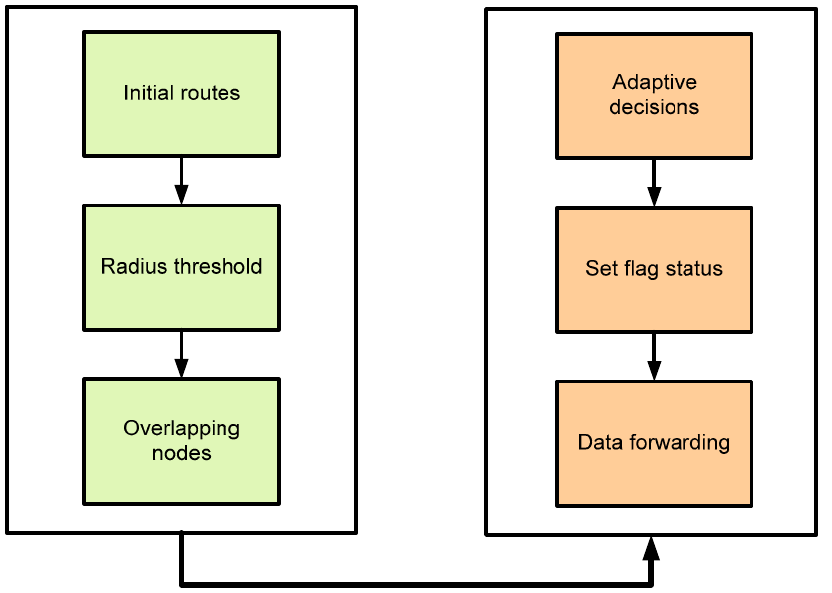
Figure 3. Developed methods for the proposed framework.